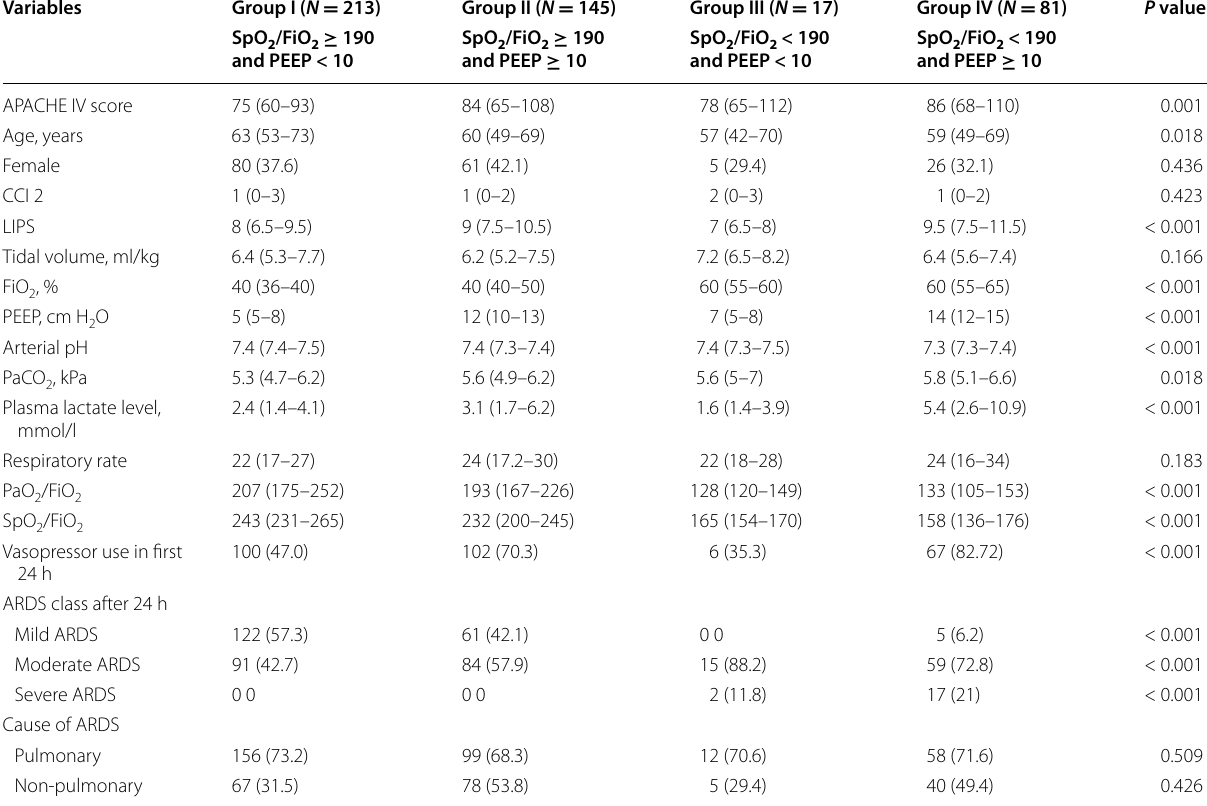
Table 4 Main characteristics of 456 patients with ARDS—classification 24 h after initial ARDS diagnosis based on SpO